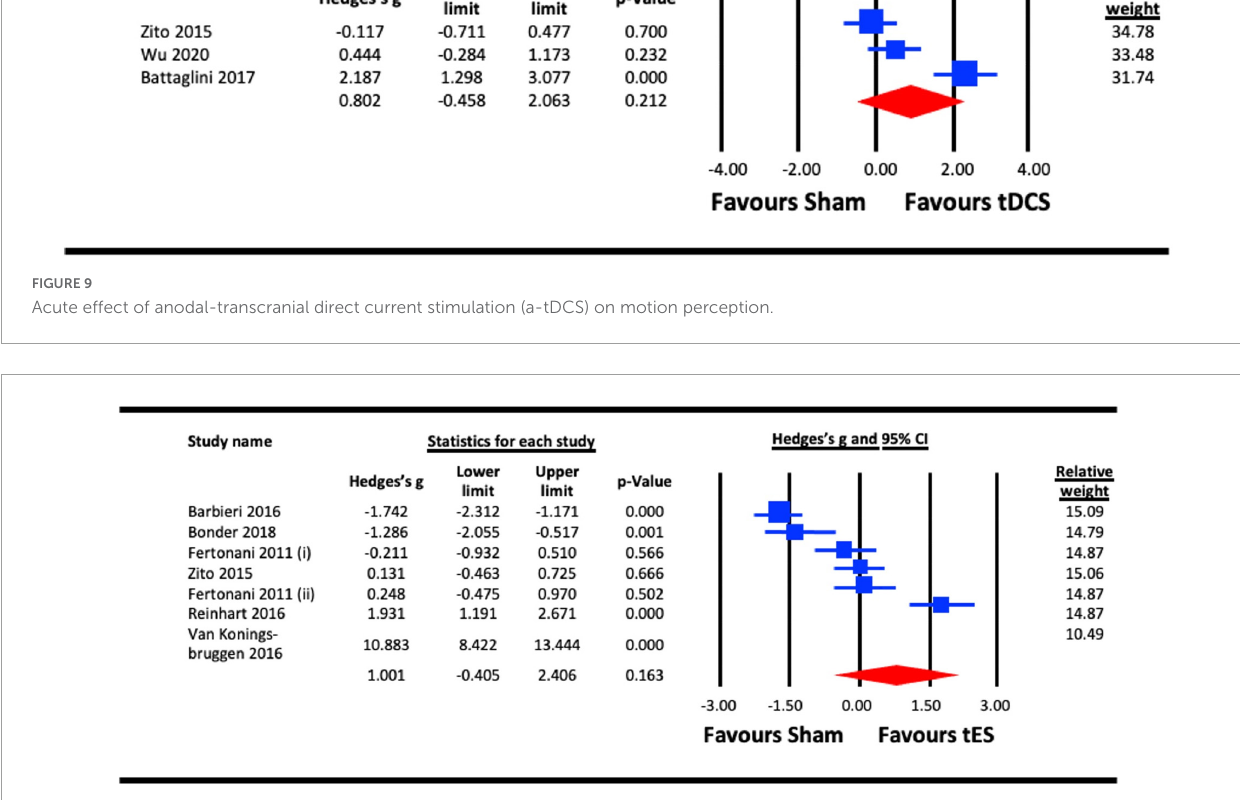
FIGURE10 Acute effect of transcranial electrical stimulation (tES) [anodal-transcranial direct current stimulation (a-tDCS) and transcranial random noise stimulation (tRNS)] on reaction time. Barbieri (2016) (included data for combined effect of a-tDCS face and object tasks); Meta-analysis for Fertonani (2011) were separated for data on a-tDCS and tRNS, represented as Fertonani (2011) (i) and Fertonani (2011) (ii).